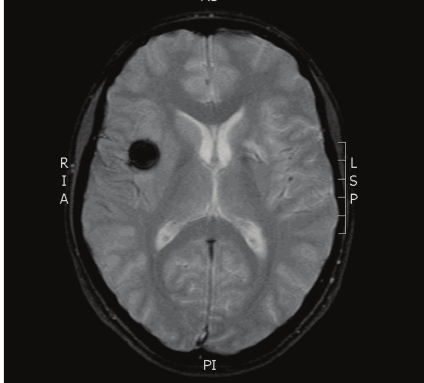
Figure 8: Cerebral angiographic (DSA) image in AP view of right ICA at 6-month follow-up, demonstrating complete obliteration of the embolized aneurysm with retrograde filling of the normal artery distal to the aneurysm. The smaller aneurysm has shown significant reduction in